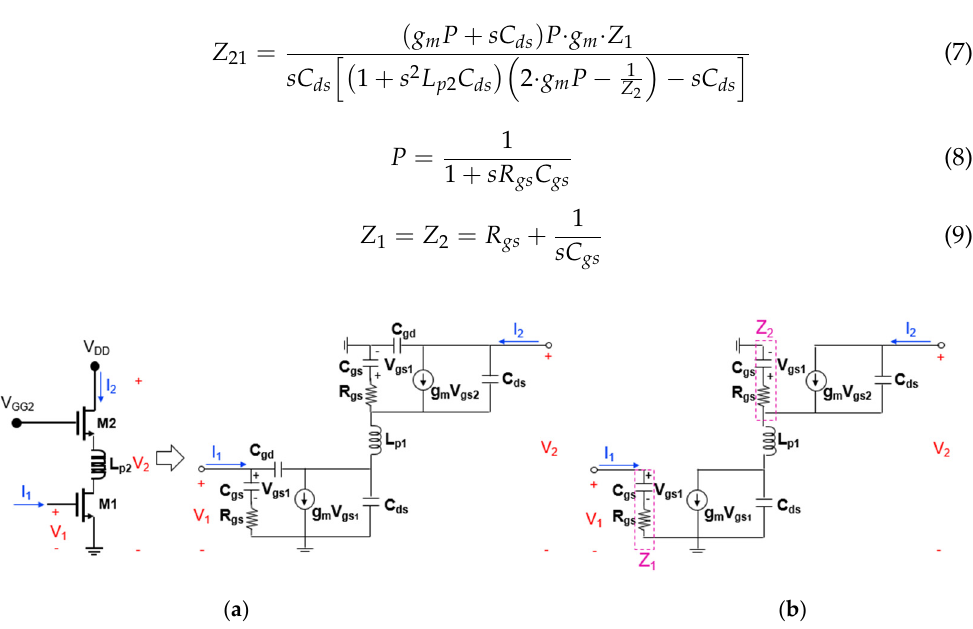
Figure 9. Transistor equivalent circuit of the cascode mixer when the second positive feedback inductor (L p2 ) is added to the source-drain connection between M1 and M2 (( a ) two-port representation and ( b ) simplified one).